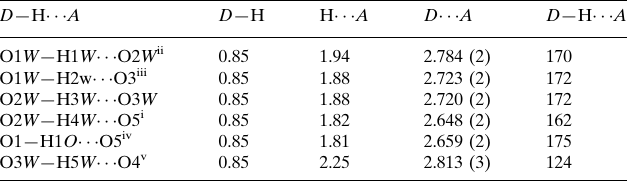
Hydrogen-bond geometry (A˚ , (cid:3)